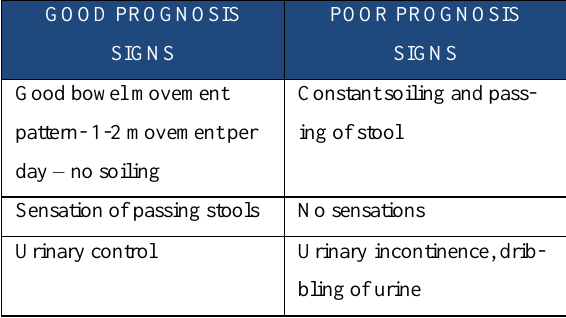
Table 3: Prognostic signs for patients with